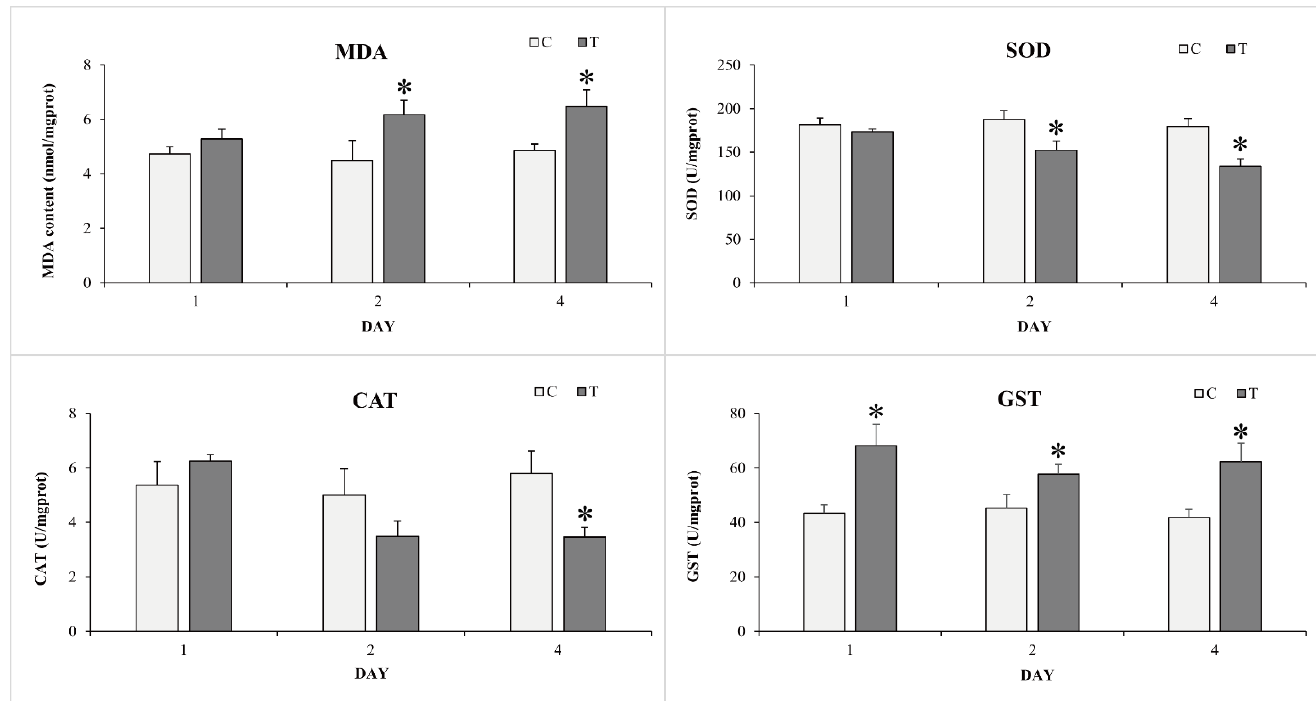
Figure 5. The MDA content and antioxidant enzyme activities (SOD, CAT, and GST) in the liver of goldfish during four days of trichloroisocyanuric acid treatment. Each bar represents mean ± SD (n = 3) and the asterisk indicates significant differences ( p < 0.05).